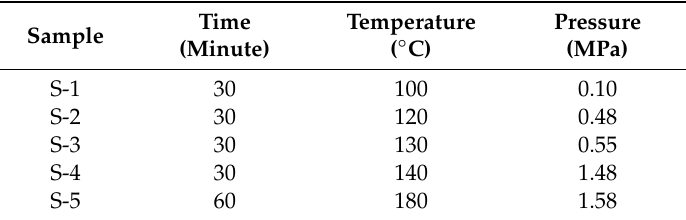
Table 3. Experimental conditions of the shale samples.